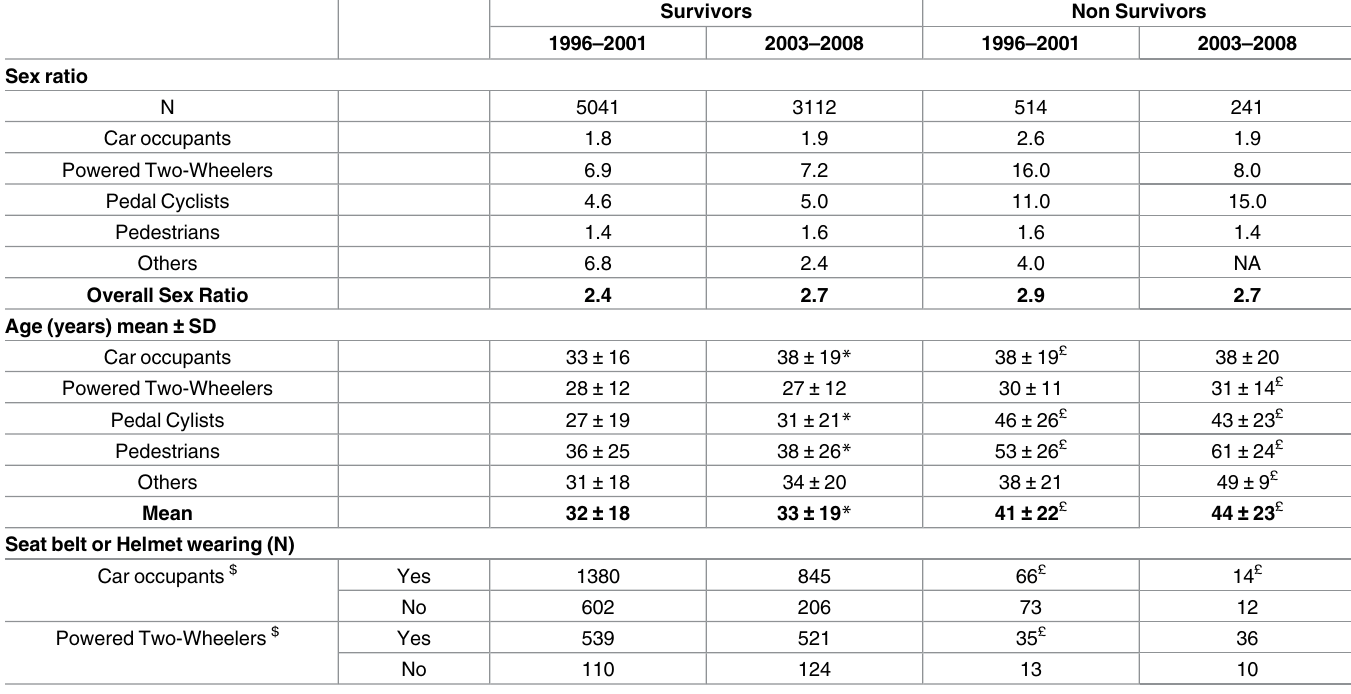
Table 5. Trend of Sex Ratio (Male/Female), age (Mean ± SD) and safety device use among road users in the two observation